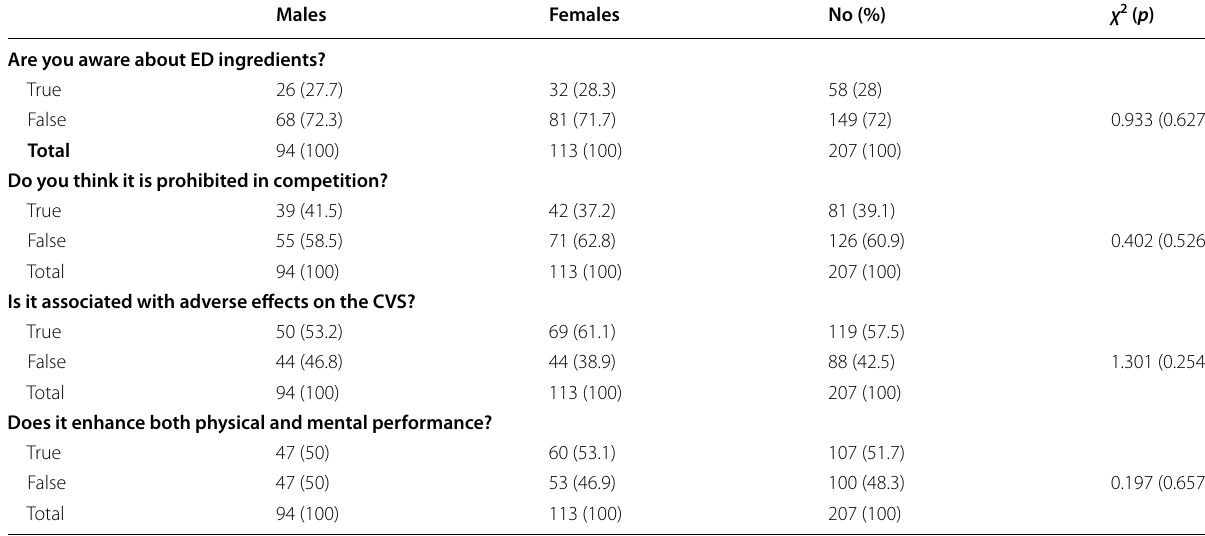
Person’s chi-square test